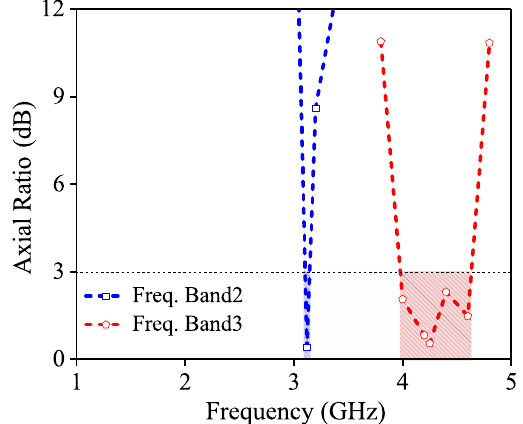
FIGURE 14: Simulated axial ratio of the proposed array geometry.